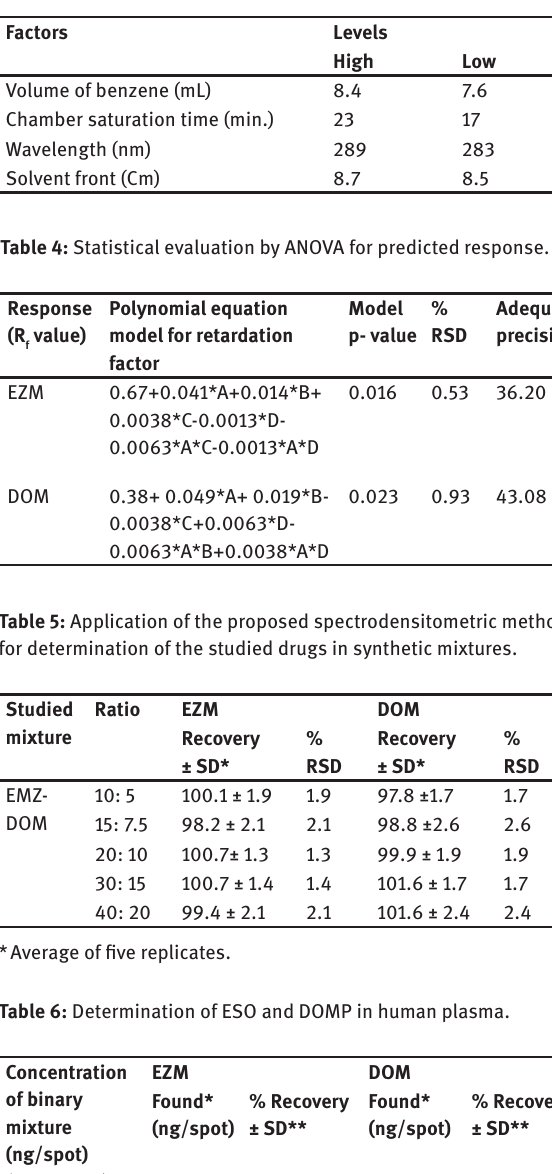
Table 3: Experimental factors and levels used in FFD.